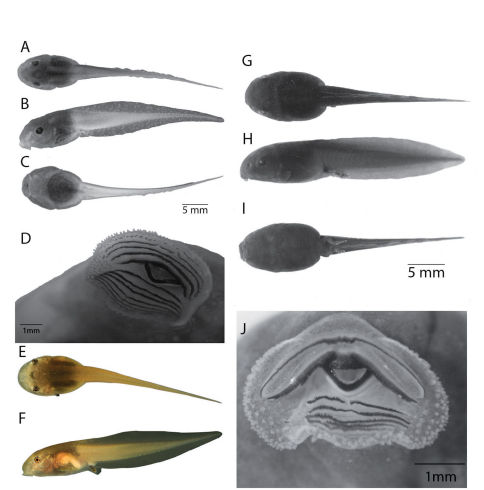
Tadpoles of Osteocephalus festae and Osteocephalus verruciger. A–D, G–J are in preservative; E–F in life. A–D: Osteocephalus festae, stage 39, QCAZ 30511; E–F: Osteocephalus festae, stage 33, QCAZ 38074; G–J: Osteocephalus verruciger,stage 36, QCAZ 36751. A, G: dorsal view; B, H: lateral view; C, I: ventral view; D, J:oral apparatus. Photos in life by SRR.